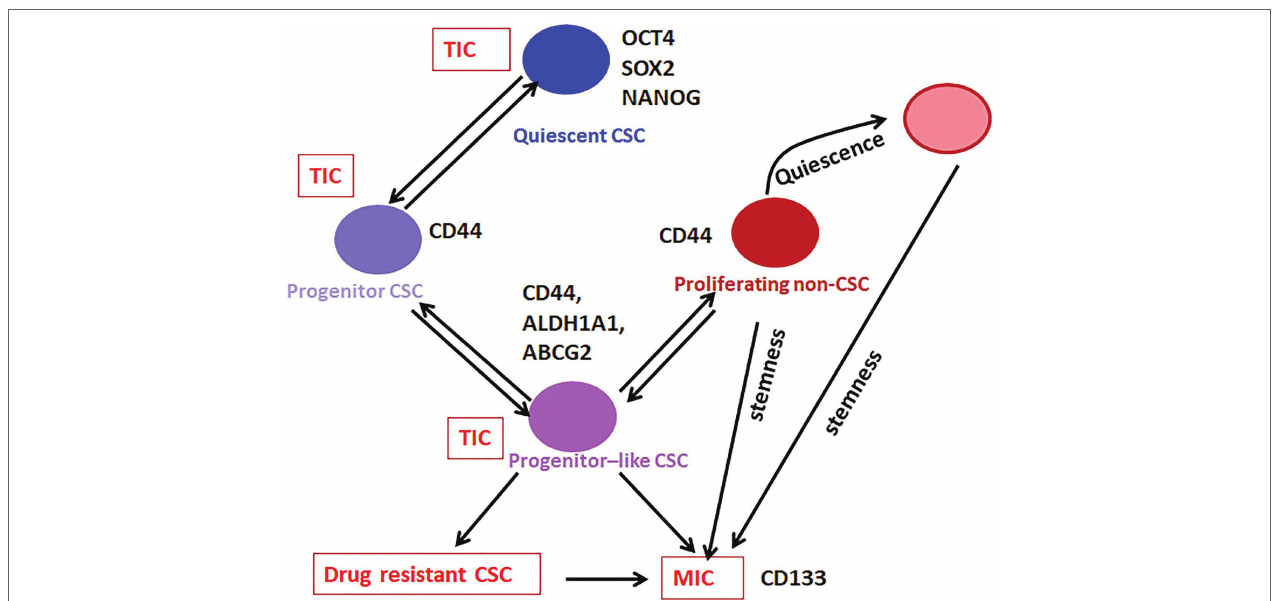
FIGURE 2 | The hierarchy in CSCs. Our analysis on the available literature on single-cell analyses conducted in breast cancer has revealed that the expression of pluripotency markers without CD44 marks the Quiescent CSC, while CD44 along with moderate expression of pluripotency markers define the Progenitor CSC population. These cells gradually lose the expression of pluripotency markers and gain the expression of ABCG2 and ALDH1A1 to get converted to Progenitor-like CSC population. According to the niche factors, these cells can be converted to the drug-resistant-CSCs or metastasis initiating cells (MICs). When this Progenitor-like CSC population loses all the CSC markers except CD44, they are converted to the Proliferating non-CSCs. The Quiescent cells, Progenitor cells, and Progenitor-like cells are considered as CSCs or tumor-initiating cells (TICs), which exhibit tumor initiation potential. The Progenitor like population having hybrid EMT phenotype might be the drug-resistant CSCs and MICs. The proliferating population with hybrid EMT might be highly metastatic, and they can remain dormant at distant sites. These cells are the seeds of recurrence at a different site. They might initiate tumor if they acquire stemness depending on the metastatic